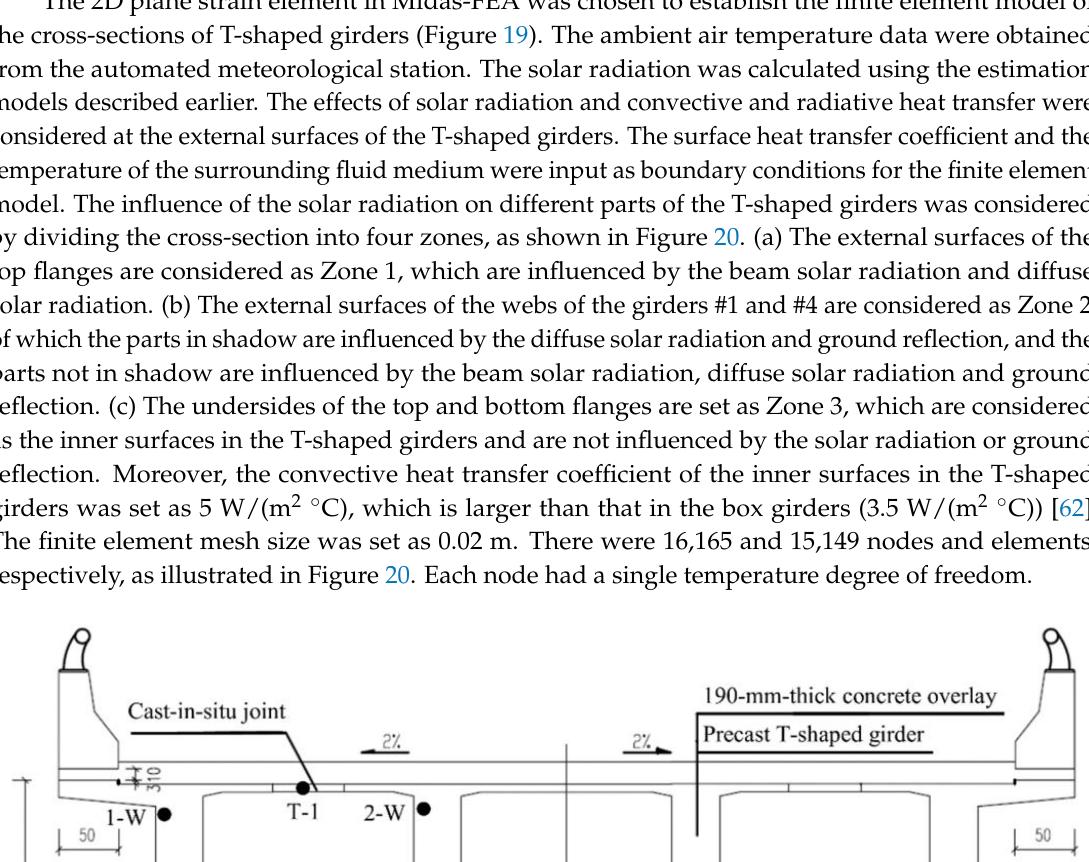
Figure 20. Finite element model of cross-section of T-shaped girder. 6.3.2. Influence of Solar Radiation on Temperature Distribution on Cross-Section of T-Shaped Girder During the monitoring period, 23 August 2012 was a sunny day with the high solar radiation. Comparisons of temperature–time curves obtained experimentally or from finite element model with or without the consideration of solar radiation are illustrated in Figure 21 (23 August 2012). The hollow points denote the measured data, the solid line denotes the calculated curves with the consideration of solar radiation, and the dash line denotes the calculated curves without the consideration of solar radiation. The temperature contour plots obtained from finite element model with or without the consideration of solar radiation are compared in Figure 22 (15:00, 23 August 2012). In Figure 21, it can be observed that the variation trends and the times at which the highest temperatures occurred are similar for measured and calculated results on 23 August 2012. The differences between the highest measured and calculated temperatures when considering the effect of solar radiation were very small (maximum 1.7 °C for top flanges and 1.0 °C for webs). However, the highest calculated temperatures without the consideration of solar radiation were lower (maximum 7.6 °C for top flanges and 3.1 °C for webs) and had a time delay (2 h for top flanges). For bottom flanges, the differences between the highest measured and calculated temperatures with and without the consideration of solar radiation were very small (maximum 0.3 °C). The accuracy of the solar radiation calculated by using the estimation models can meet the engineering requirements. In Figure 22, it can be observed that the differences between the highest calculated temperatures with or without the consideration of solar radiation were significant at 15:00 on 23 August 2012 (maximum 13.5 °C). The vertical temperature variation on the cross-section of T-shaped girder when considering the effect of solar radiation (19.7 °C) was significantly larger than that without the consideration of solar radiation (6.5 °C) in summer. Therefore, the influence of solar radiation should be considered in the analyses of the temperature distribution on T-shaped girders, especially for top flanges and webs.